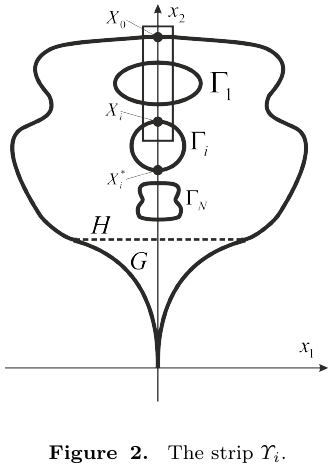
Figure 2. The strip Υ i